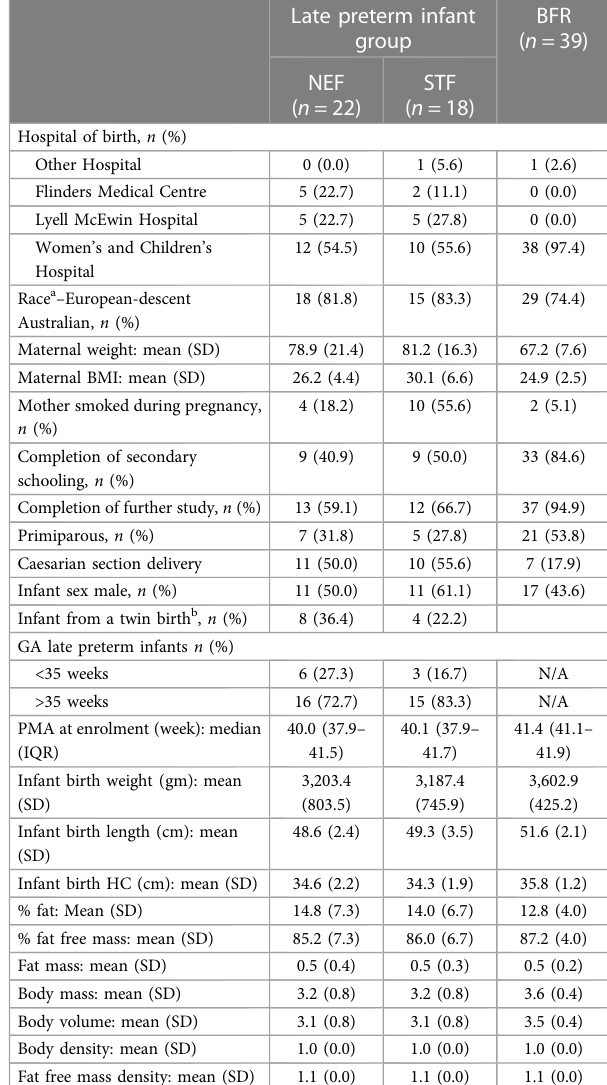
TABLE 1 Baseline maternal and infant